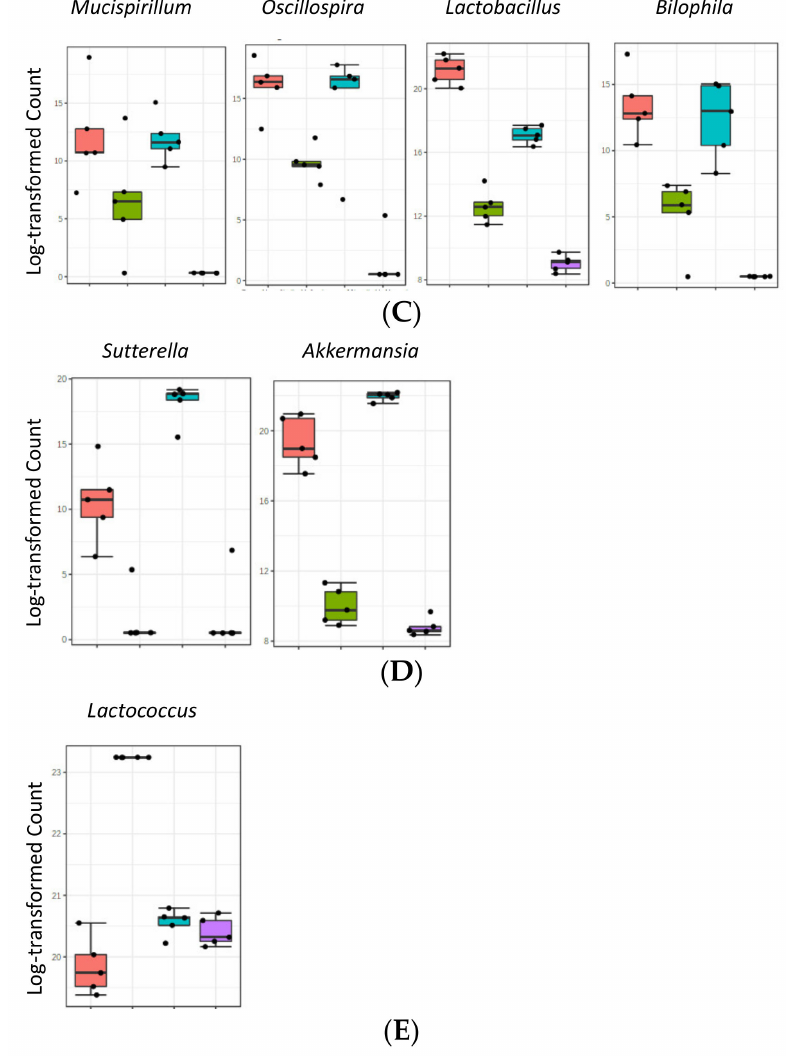
Figure 6. Bacterial genera showing differences between treatment groups . LEfSe analysis [23] was performed to detect fecal bacterial taxa that differed in abundance in a particular treatment. The different box-plots represent abundance (log transformation of data normalized by total-sum scaling × 10 7 ) of bacterial genera with LDA scores > 4 when all treatment groups were analyzed. ( A ) Bacterial genera increased in hFMT; ( B ) Genera ablated or lowered by Ab treatment; ( C ) Genera partially restored by self-FMT; ( D ) Genera increased after self-FMT; ( E ). Genera increased in Ab-group. Red, control animals; green, Ab-treated animals; blue, Self-FMT; magenta, hFMT. Ab, antibiotic; hFMT, human fecal microbiota transplantation; self-FMT, self-fecal microbiota